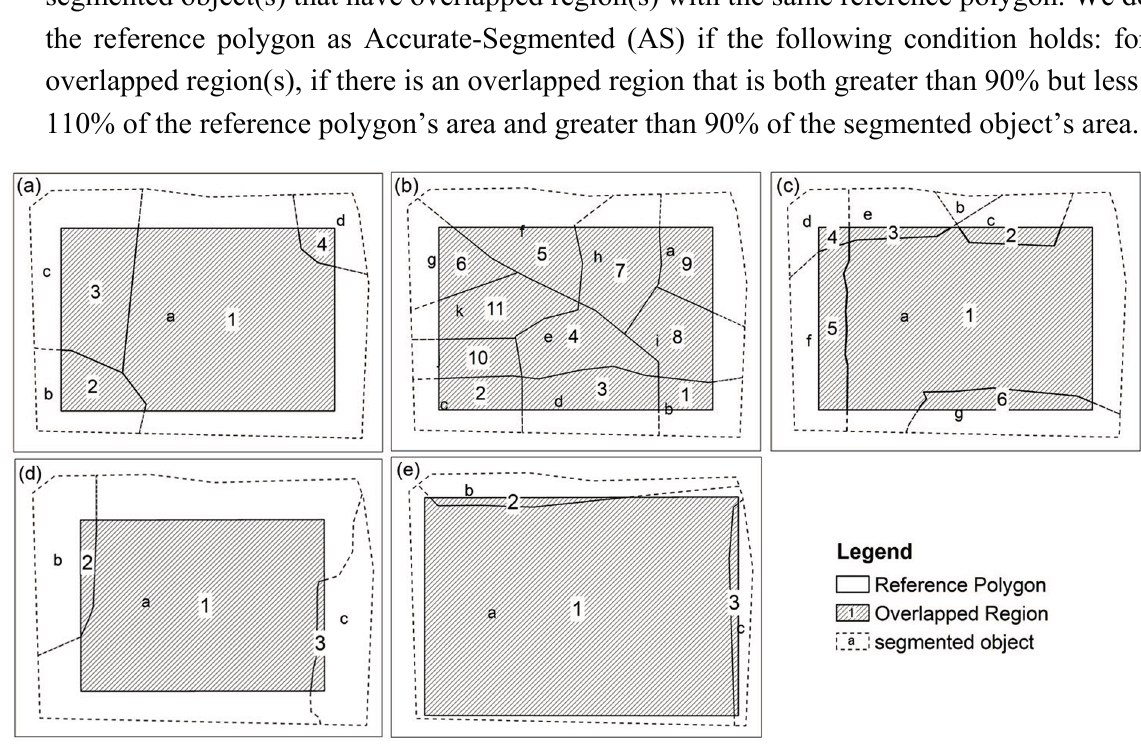
Figure 5. Illustrations of Over-Segmented ( a – c ), Under-Segmented ( d ), and Accurate-Segmented ( e ) objects. In (a), more than three Overlapped Regions are greater than 10% of the Reference Polygon; in (b), there are 11 Overlapped Regions, but each of them is less than 10% of the Reference polygon’s area; under condition (c), only one Overlapped Region is greater than 10% of the Reference Polygon’s area, but the region is less than 90% of the Reference Polygon’s area. In (d), only one Overlapped Region is greater than 90% of the Reference Polygon’s area, but the Overlapped Region is less than 90% of the segmented object’s area (image object a in (d)). In (e), only one Overlapped Region is both greater than 90% of the Reference Polygon’s area and 90% of the segmented object’s area (image object a in